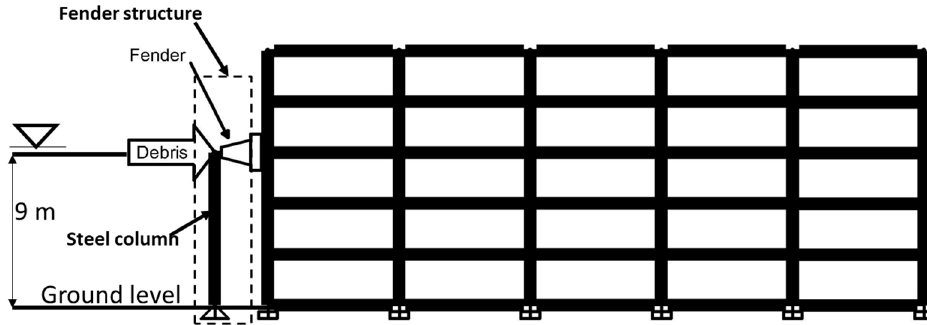
Figure 1. Building and fender structure.